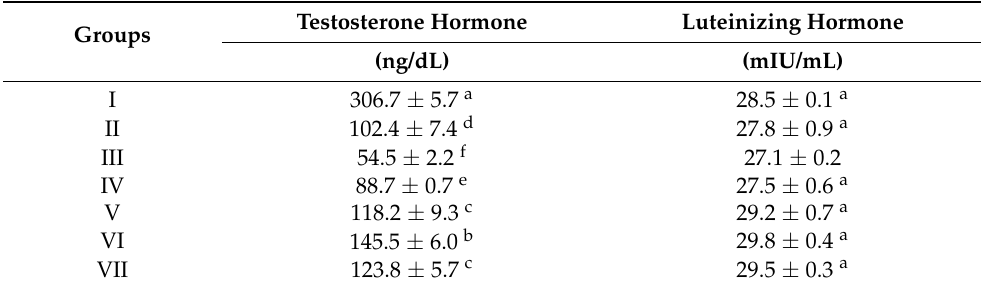
Table 2. Testosterone and luteinizing hormone levels from L-NAME-stressed rats treated with TN and WN supplemented